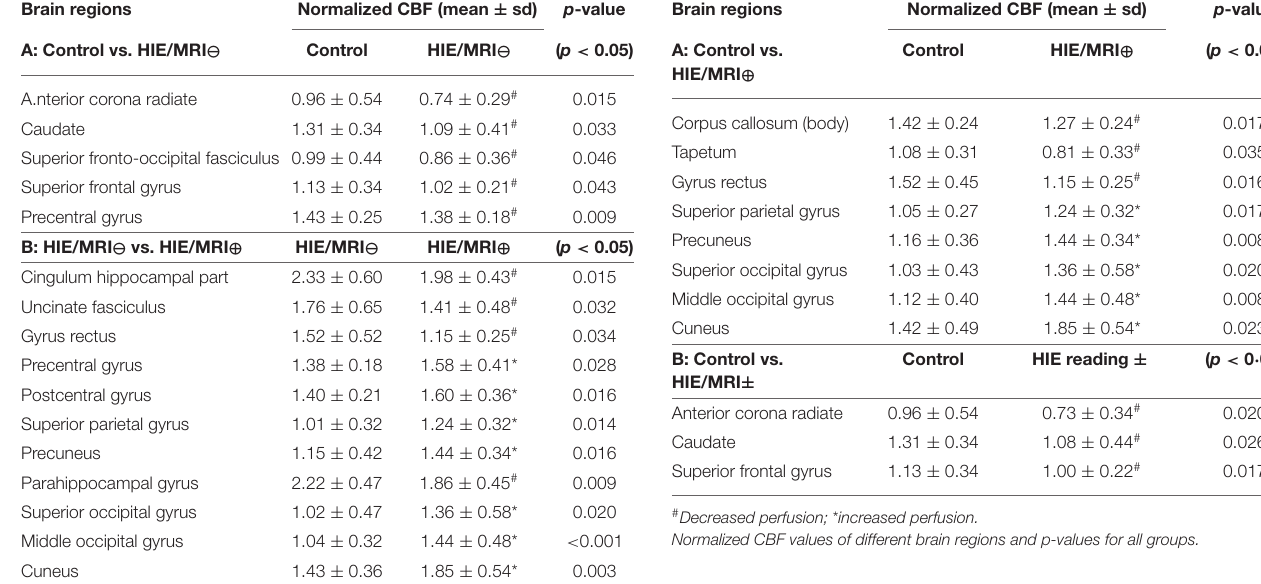
TABLE 3 | Brain regions with significant perfusion differences between control and HIE/MRI ⊖ groups, and between control and HIE/MRI ± groups. Brain